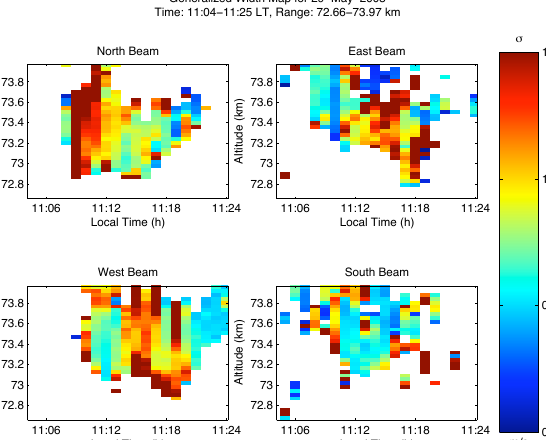
Fig. 19. SNR map in all four beams of event at 69.6 km on May 28, 2003 at 10:30 LT.